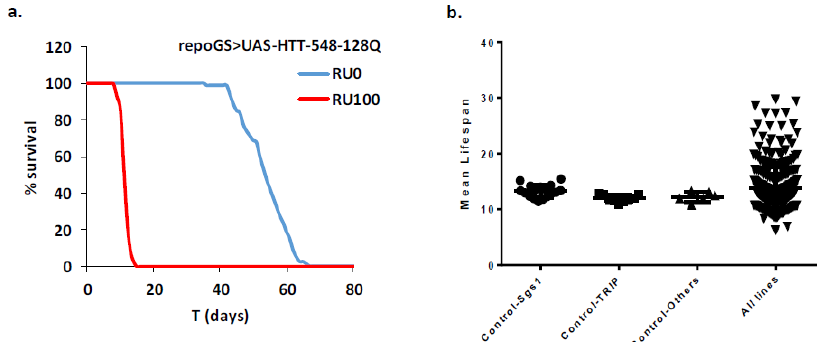
Figure 1. Identification of HD modifiers in Drosophila glial cells. ( a ) Progeny issued from a cross between the GeneSwitch repoGS line and a UAS-HTT-548-128Q transgenic line exhibit strongly reduced lifespan (mean lifespan (MLS) = 10.7, n = 205) when induced with 100 µg/mL of RU486 incorporated in the food at the emergence (RU100), compared to uninduced flies (RU0, MLS = 52.8, n = 80, pLogRank < 10 −10 ). ( b ) A repoGS > UAS-HTT-548-128Q line was crossed with lines to be tested or to various control lines (see Materials and Methods and Table S4 for detailed genotypes) and the MLS of the progeny was scored. The distribution of the MLS was highly reproducible for the controls (MLS = 13.2, 12.0, 12.2; SD = 1.13, 0.66, 0.92; Nexp = 17, 9, 6, respectively, from left to right) while a large dispersion of the MLS in tested lines illustrates the identification of HD modifiers. With a threshold of >20% MLS fold change, 24 enhancers and 22 suppressors were identified.